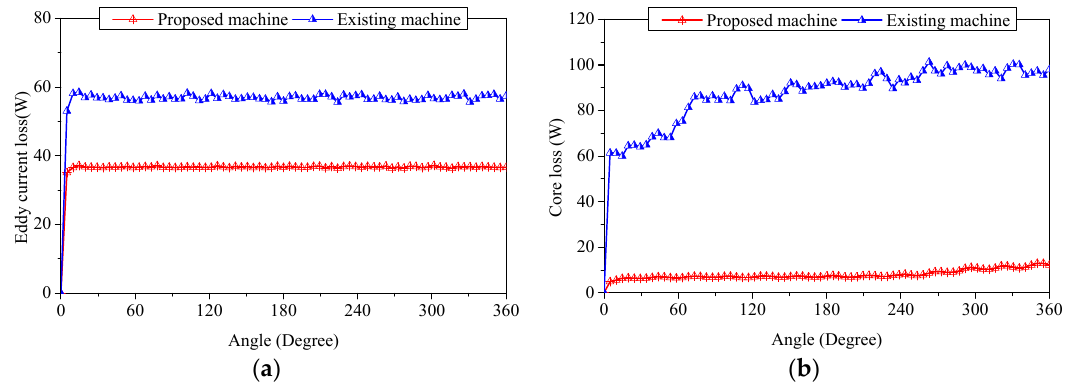
Figure 20. Losses at the full operation: ( a ) eddy current loss; and ( b ) core loss.